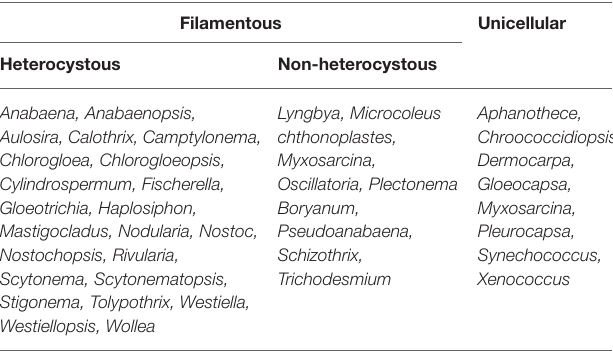
TABLE 1 | List of nitrogen-fixing cyanobacteria important for their application in biofertilizer industry (adapted from Vaishampayan et al.,